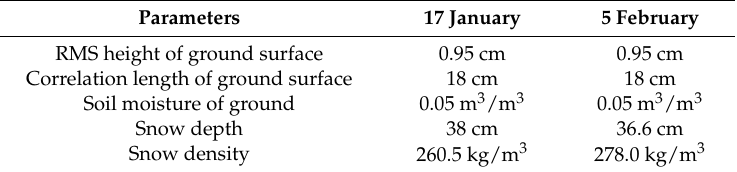
Table 2. SARALPS-2007 field measurements of snow properties on 17 January and 5